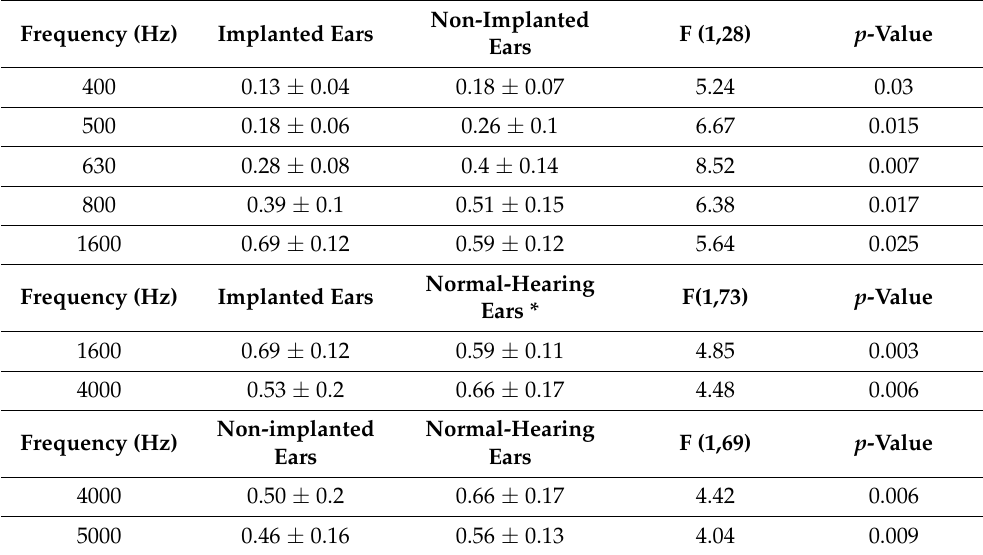
Table 3. Average absorbance (across the pressure settings) of the implanted ears, the contra-lateral non-implanted ears, and ears with normal hearing. The F and p values of the differences are also displayed. Only frequencies where the differences between conditions were statistically significant are shown in the table